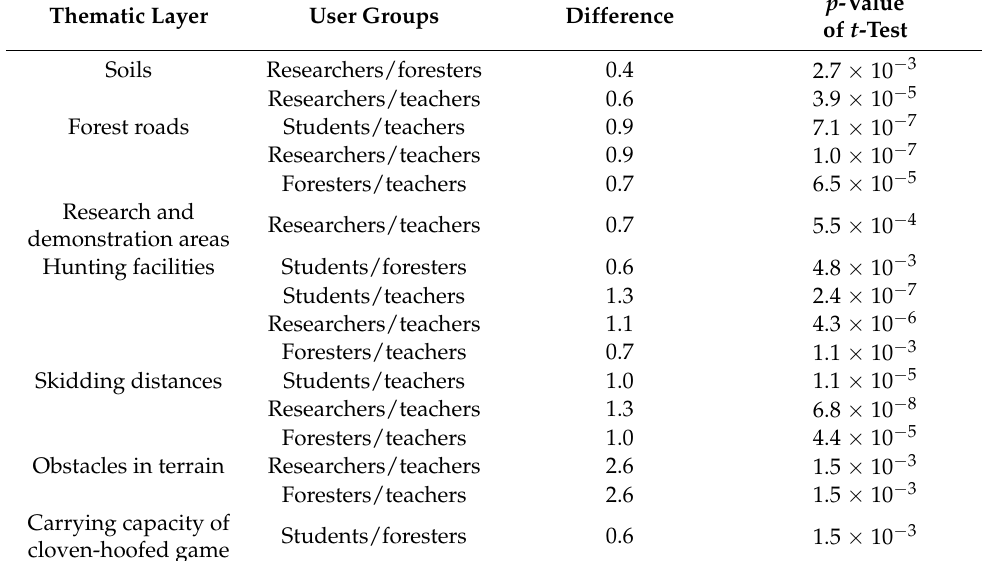
Table A6. Significant differences in the geographical data rating by user group.